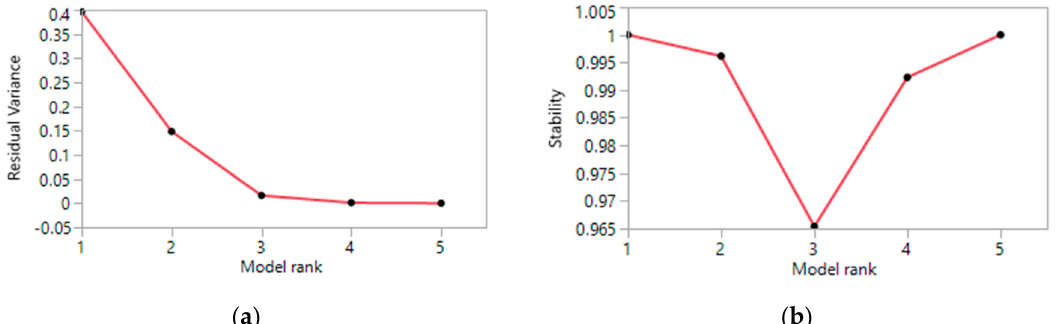
Figure 3. ( a ) Residual sum of squares; ( b ) Clustering stability.